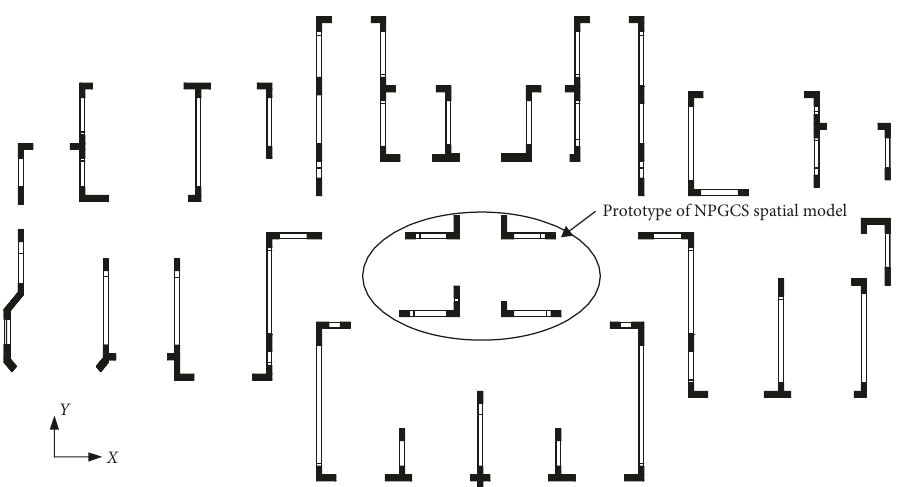
Figure 3: The NPGCS spatial model prototype in the key floor.